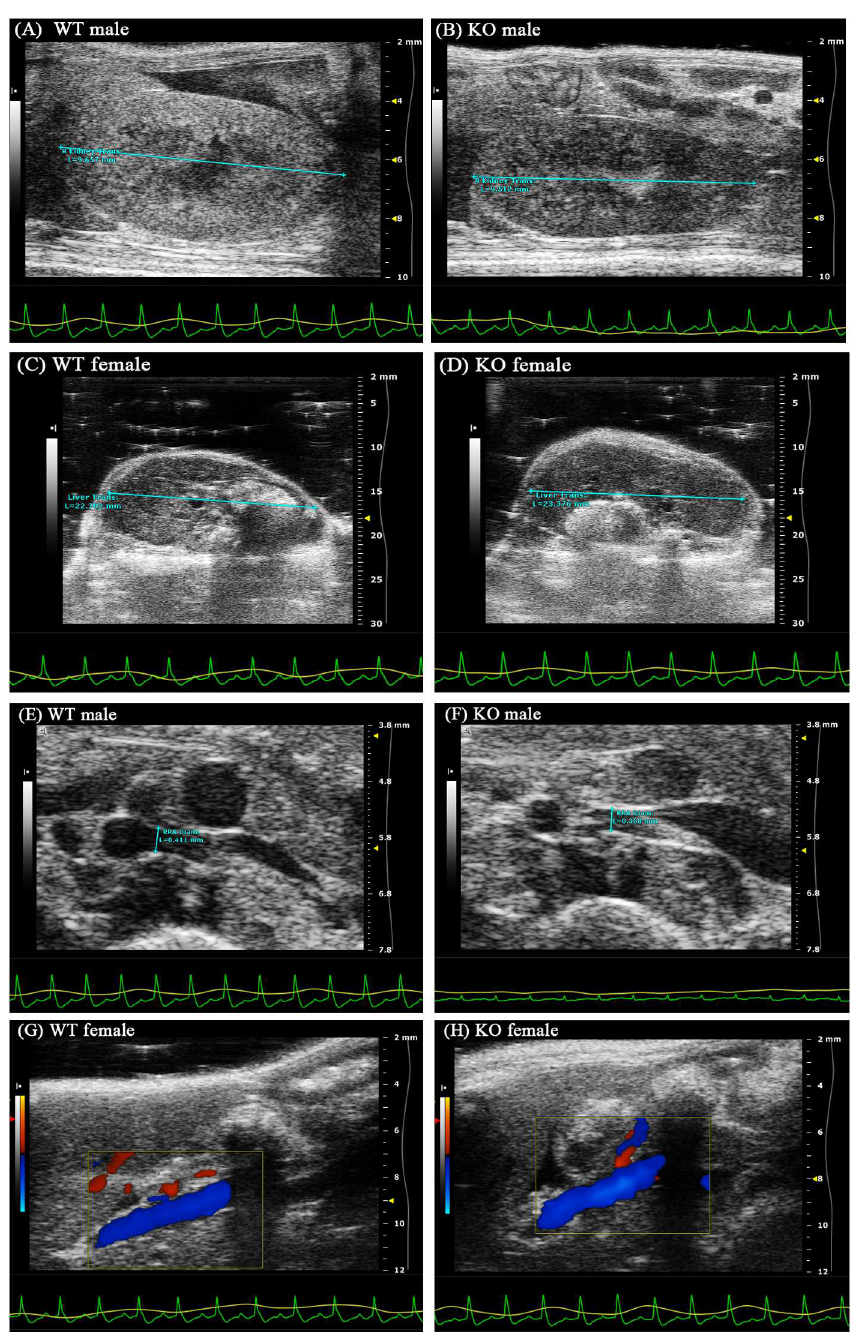
Fig 2. Representative parameters of the kidney and liver. The liver and kidney parameterswere measuredand recordedbasedon ultrasoundexaminations. (A and B) Transverse kidney; (C and D) Transverse liver; (E and F) RA diameter; and (G and H) PV visualization. The parameters showedno significantdifferences in any of the evaluatedindices. (Mice were 8 weeks